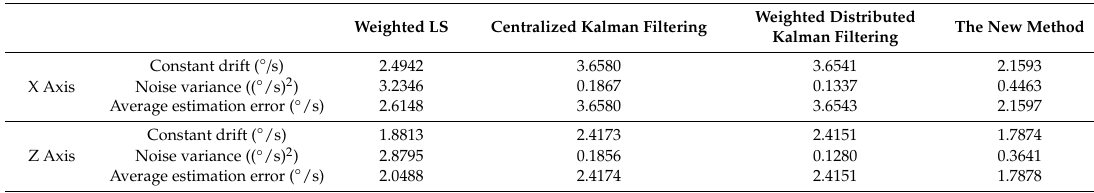
Figure 16. The fusion results for the case of two constant drift faults. ( a ) X Axis; ( b ) Z Axis. Table 7. The details of the fusion signal